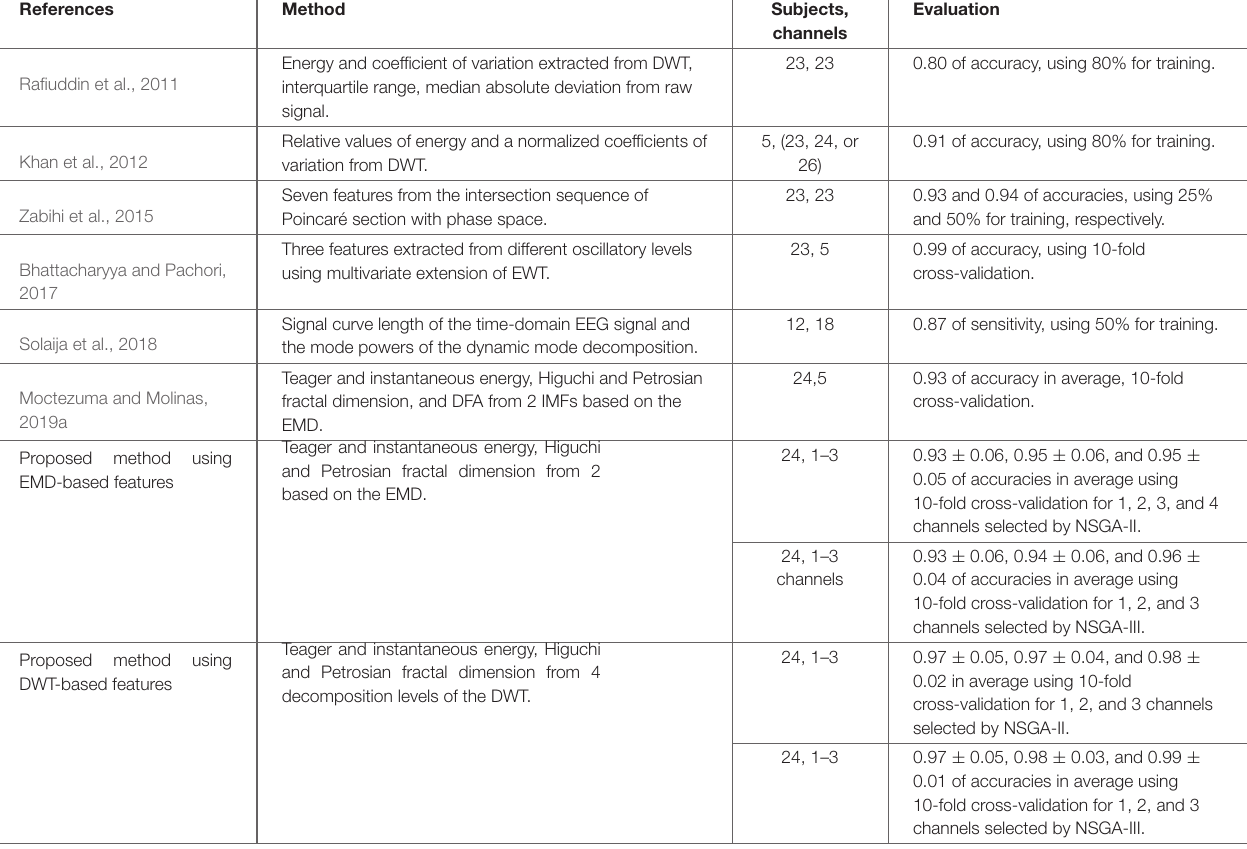
TABLE 5 | Comparison of relevant existing methods for epileptic seizures classification using the CHB-MIT Scalp EEG dataset presented in Shoeb (2009).